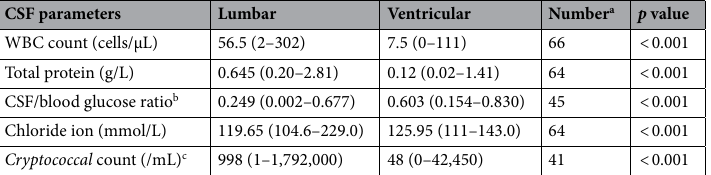
Table 2. Comparison of lumbar and ventricular CSF parameters. Data presented as the median [Range]. a Patients who had both lumbar and ventricular CSF test. b 19 patients lacked contemporaneous blood glucose values. c Only included patients who had positive result of India ink staining before VPS surgery.